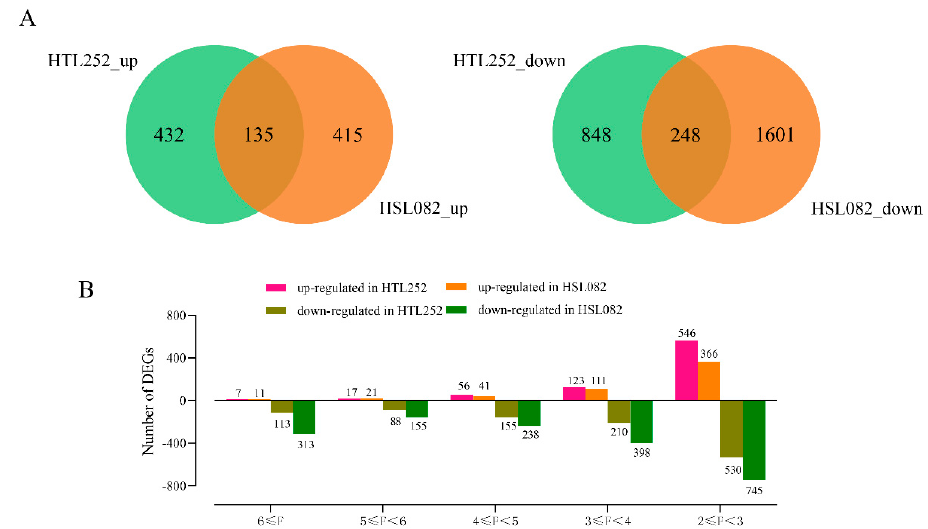
Figure 1. ( A ) Venn diagram of DEGs in HTL252 and HSL082 under HS. HTL252_up indicates the upregulated genes in HTL252, HSL082_up represents the upregulated genes in HSL082, HTL252_down indicates the downregulated genes in HTL252, and HSL082_down stands for the downregulated genes in HSL082. ( B ) Distribution of DEGs according to fold-changes F. Negative log base 2 changes in fold indicate repression, while positive values represent induction. Y -axis indicates the number of upregulated or downregulated DEGs. The part of Y -axis above 0 stands for upregulation, and that below 0 represents downregulation. X -axis indicates the range of variation of F.